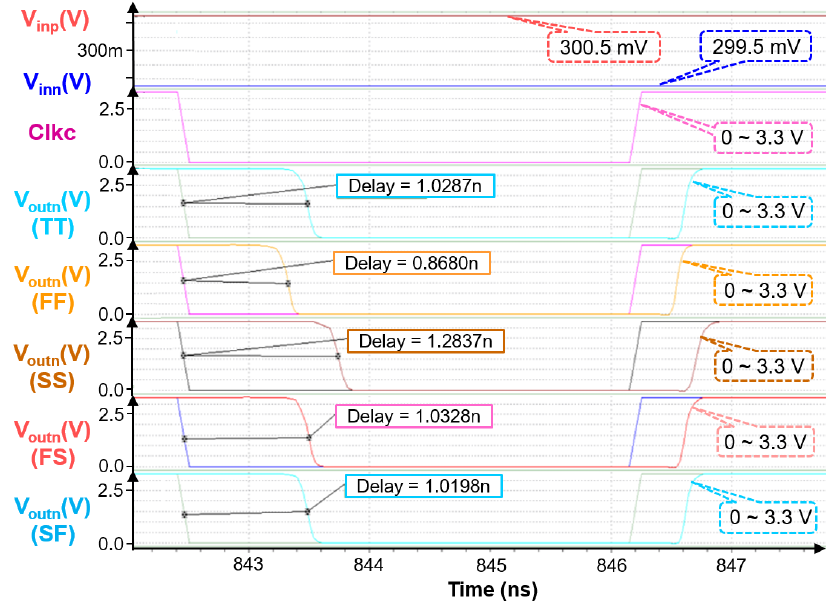
Figure 17. Simulated propagation delays at five process corners with common-mode voltage of 300 mV.